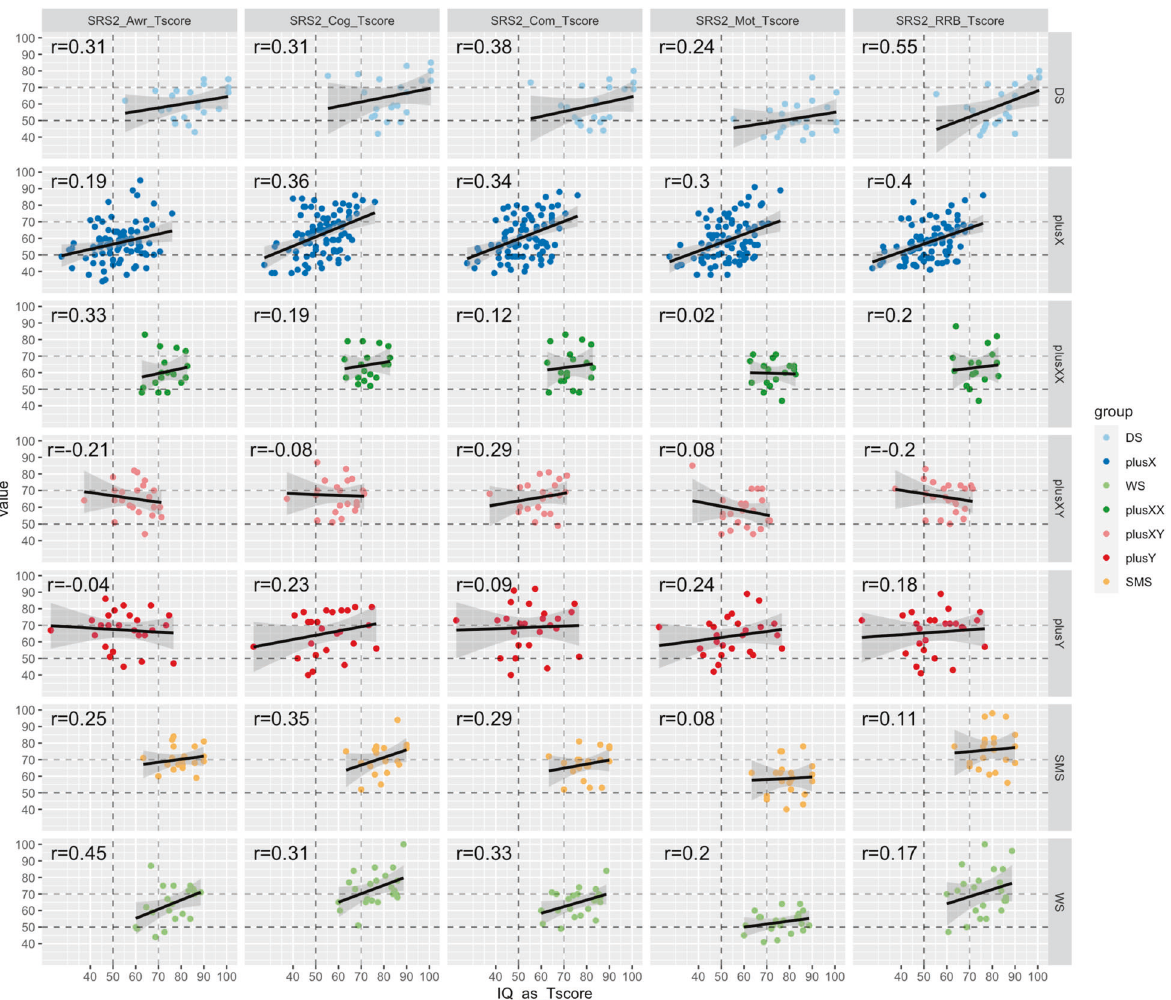
Fig. 4 Relationships between autism-related trait (ART) scores and cognitive impairment within each gene dosage disorder (GDD). Scatterplots and linear fi t lines showing the relationship between increasing cognitive impairment ( x -axis: “ IQ_as_Tscore ” ) and ART score value ( y -axis) faceted by GDD (rows) and ART subscale (columns). Robust correlation coef fi cients are provided for each cell. Color encodes GDD. Dashed lines show population norm values (50, black) and 2 standard deviations above this norm (70, gray). Note that IQ is inverted and transformed to a distribution with mean = 50, sd = 10 to form “ IQ_as_Tscore ” (i.e., IQ_as_Tscore > 70 is equivalent to IQ <